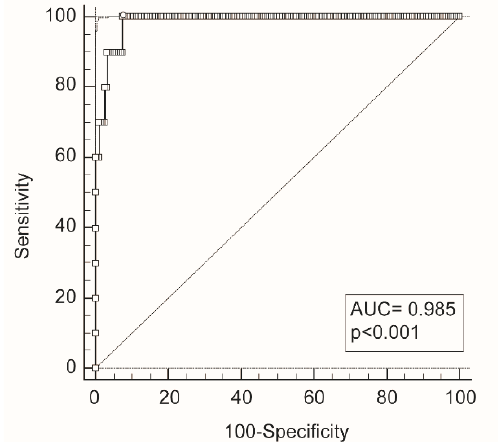
Figure 2. ROC curve of age, calprotectin levels and neutrophil count combined together. The weight of each parameter was obtained by logistic regression. The ROC curve is indicated by a bold line and full circles represent the different criterion points. The open circle indicates the best cut-off point. The dotted line indicates the bisector. AUC = area under the curve.